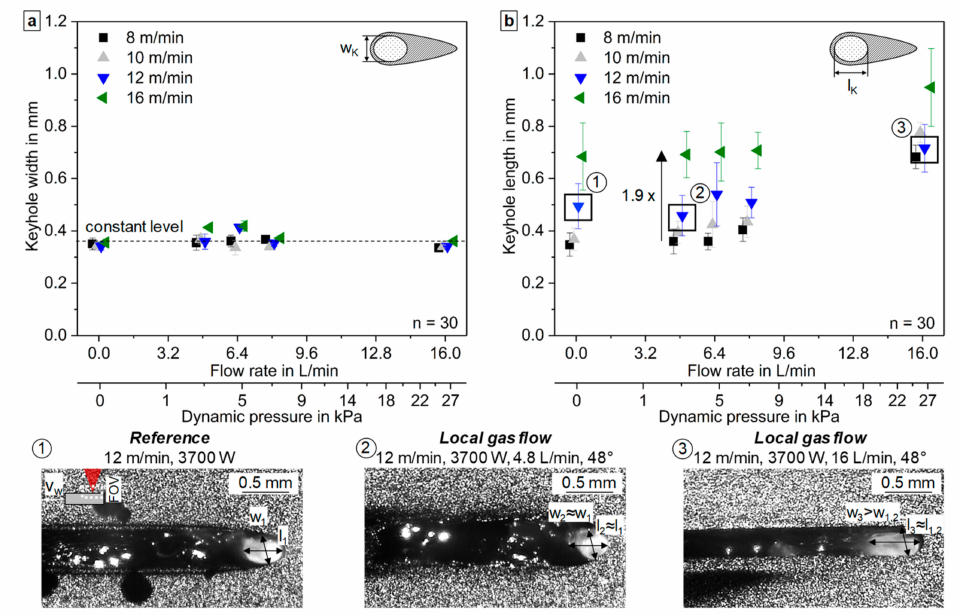
Figure 8. Keyhole dimensions as function of welding speed and flow rate: ( a ) Keyhole width; ( b ) Keyhole